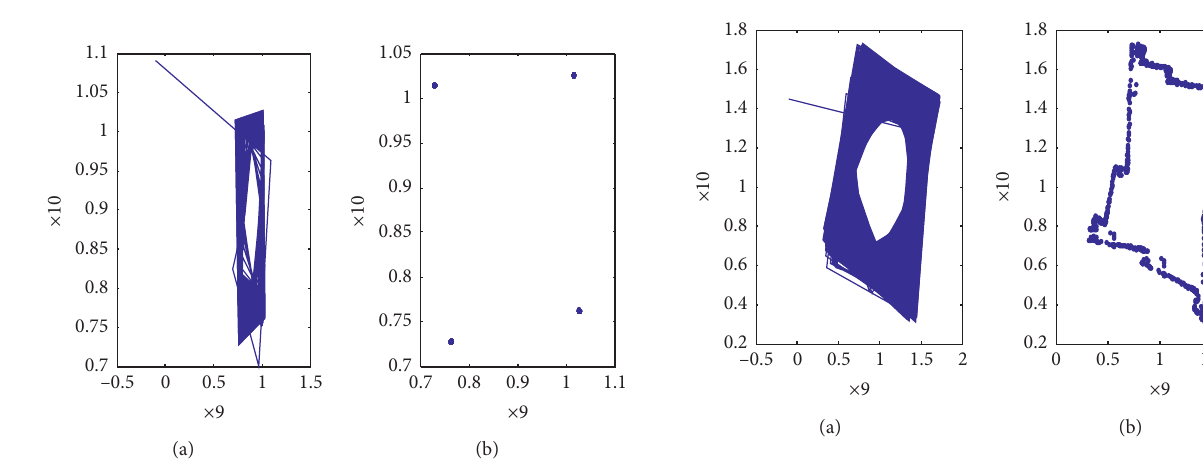
� 0 with the smoothed Coulomb model w